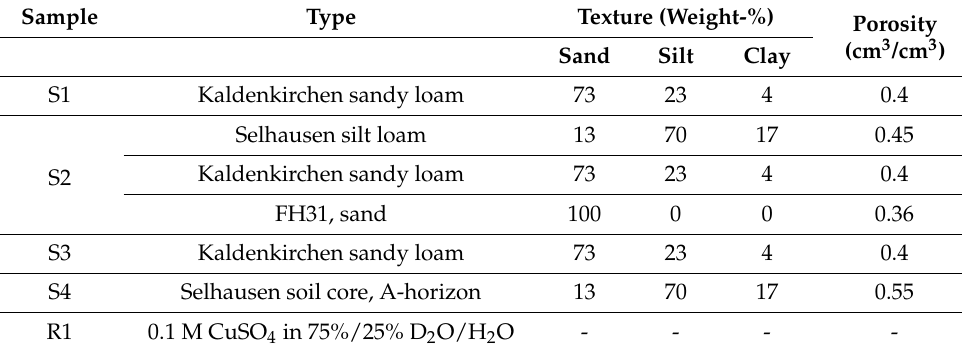
Figure 2. Saturated sandy loam sample S1. ( a ) FID with real and imaginary part in green and red. ( b ) NMR magnitude spectrum. The linewidth is 2.09 kHz corresponding to T 2 * = 0.15 ms. ( c ) Relaxation spectra from a selected region of interest (ROI) centered in one cuvette. The T 2 spectrum was obtained by inverse Laplace transformation of the average intensity of a ROI mapped by a multislice multiecho imaging pulse sequence using an echo time of 1.6 ms and 32 echoes. The T 1 spectrum was obtained from a series of images measured by a multislice single echo imaging pulse sequence with IR preparation with inversion times between 4.2 ms and 300 ms. The average T 1 is 50 ms, T 2 exhibits a fast mode of 3 ms and a slower mode at 20 ms. Table 1. Description of the samples.